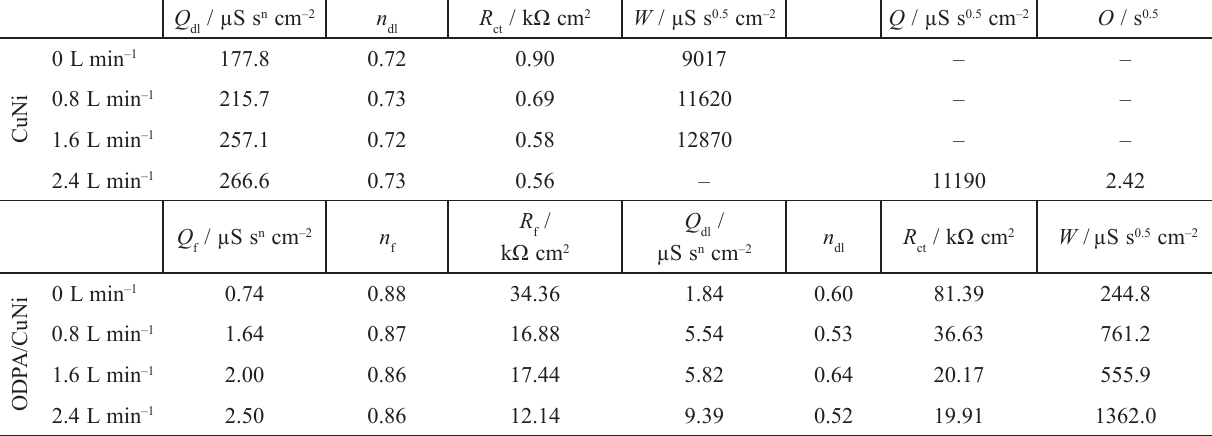
Table 2 – Impedance parameters obtained for CuNi alloy in